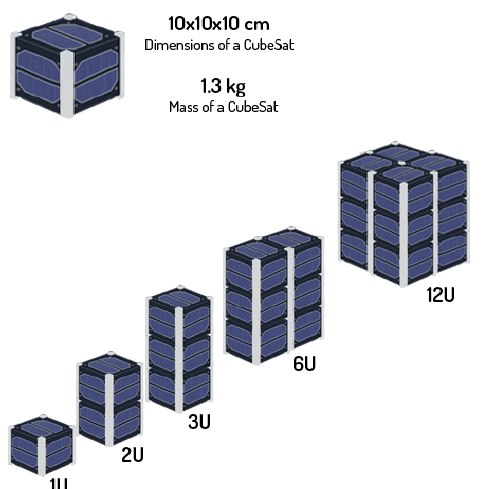
Figure 3. Common standard Cubesat units